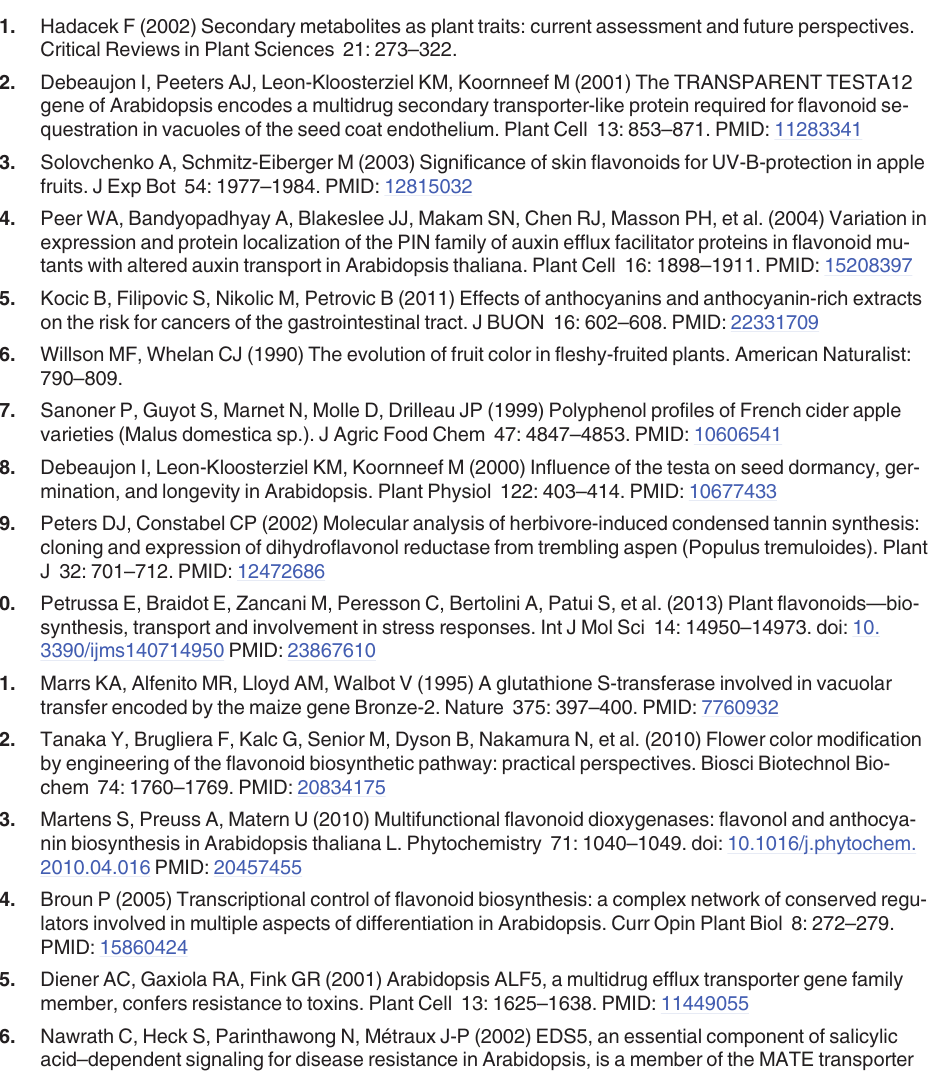
S4 Table. Primers used for real-time quantitative RT-PCR experiments.